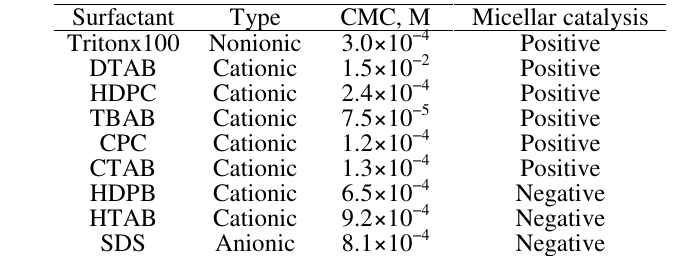
Figure 5 . Influence of BrO 3− on the sensitivity. Conditions: 100 ng/mL V(V); H Triton- x -100, 0.01 M; MG, 1.72 × 10 -5 M; temperature, 23 °C and time of 2.0 min from initiation of the reaction Table 1. Surfactant tested us a potential micellar catalyst for the enhanced rate of MG-BrO -V(V) reaction